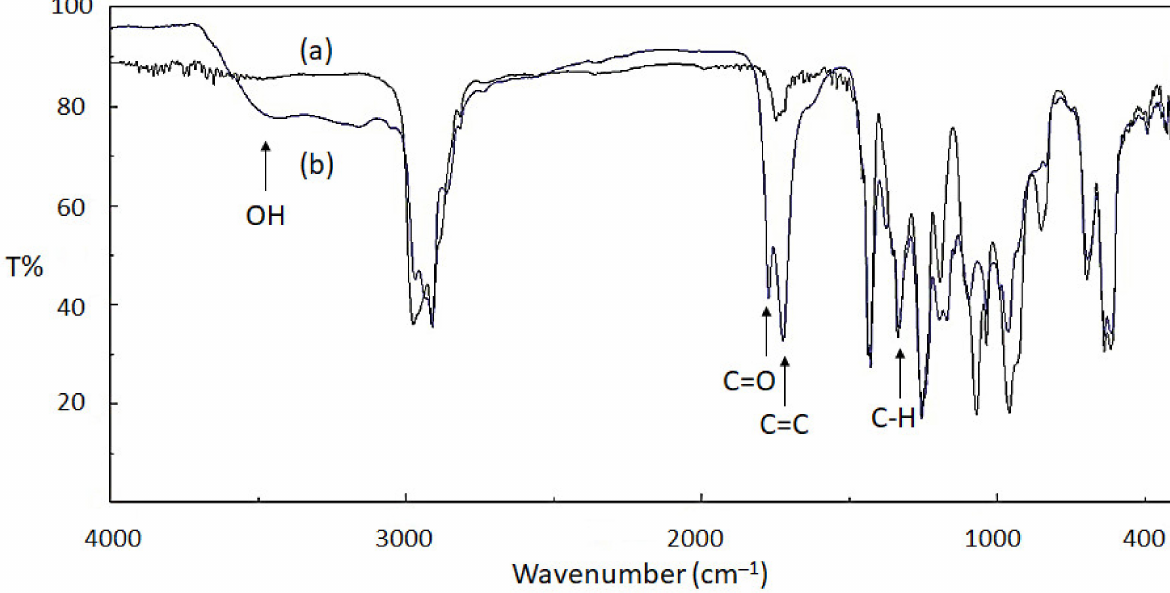
Figure 1. FTIR spectra of poly(vinyl chloride) (PVC) (blank): ( a ) Before irradiation and ( b ) after